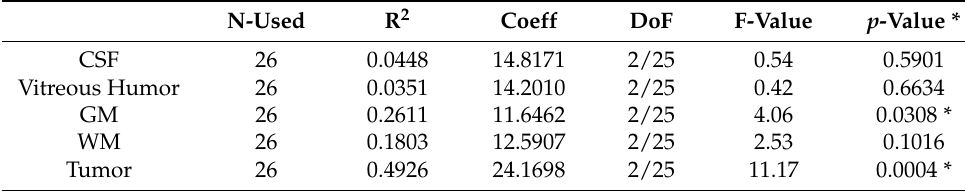
Table 1. ANOVA of 23 Na of Uninvolved Structures and Pediatric